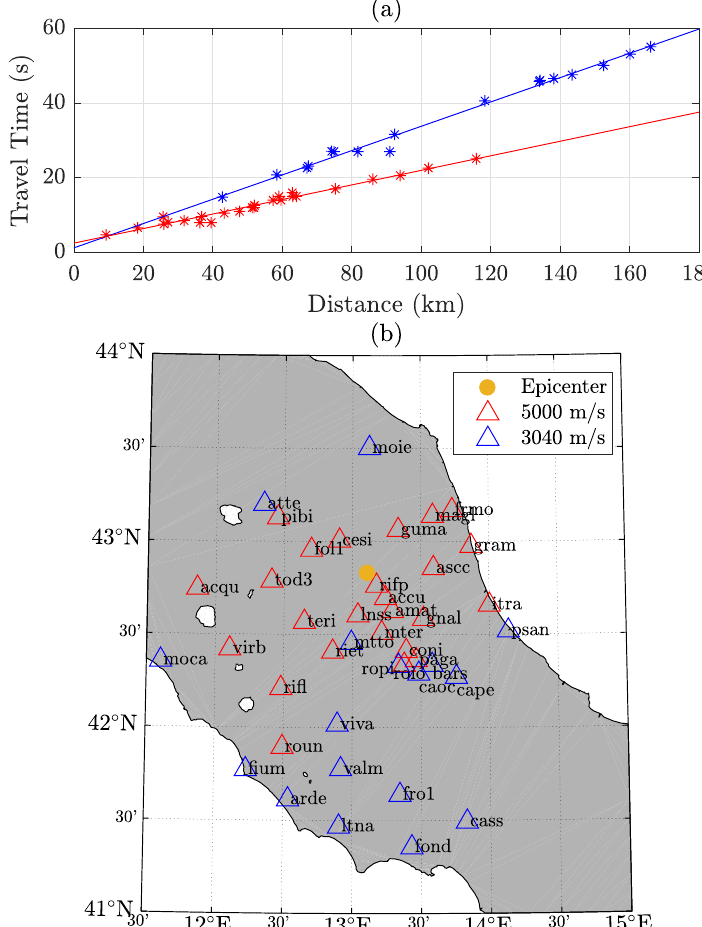
Figure 2. Plot ( a ): Seismic travel times from GNSS (w.r.t. reference origin time) with regard to epicentral station distances, and regression lines for the two seismic phases that were identified. Plot ( b ): GNSS stations with the seismic phases of plot ( a ) assigned. The observed radiation pattern agrees well with the reported fault